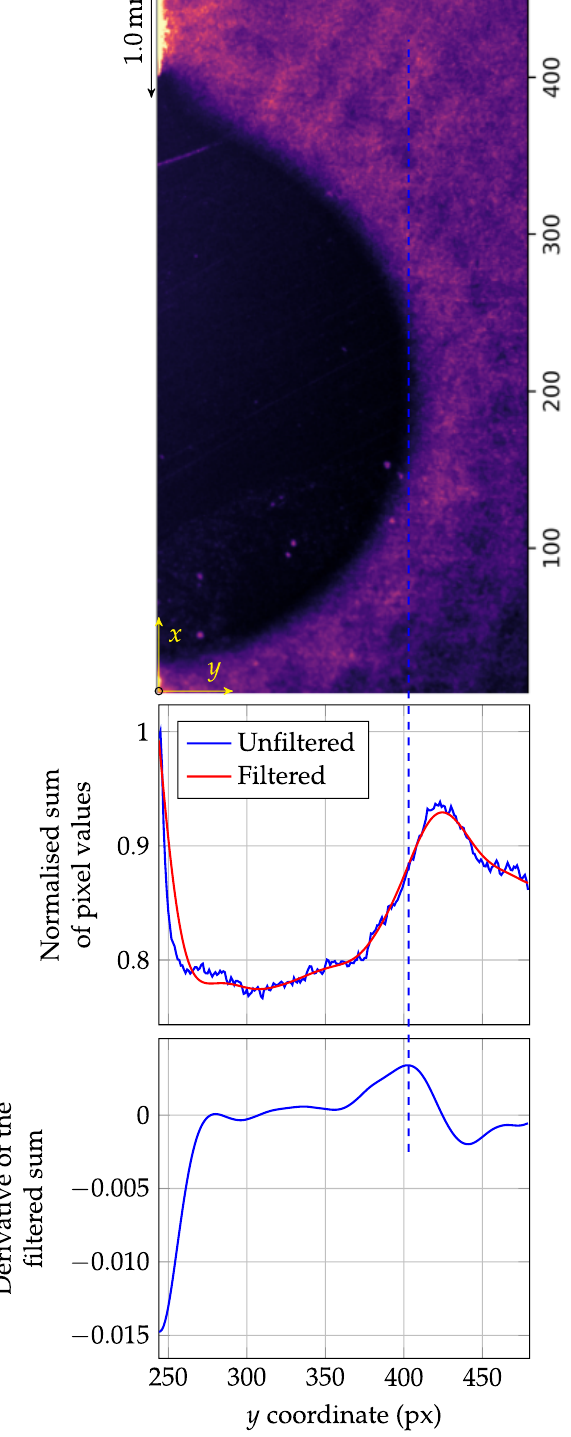
Figure 8. Determination of the penetration limit through the global maxima of the normalised sum of pixel values’ first